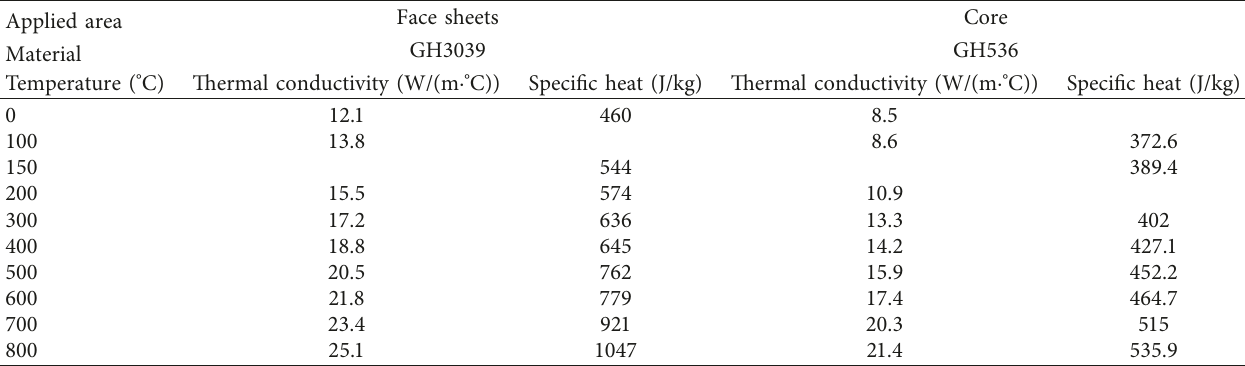
Table 1: Material properties for the experimental honeycomb sandwich panel.